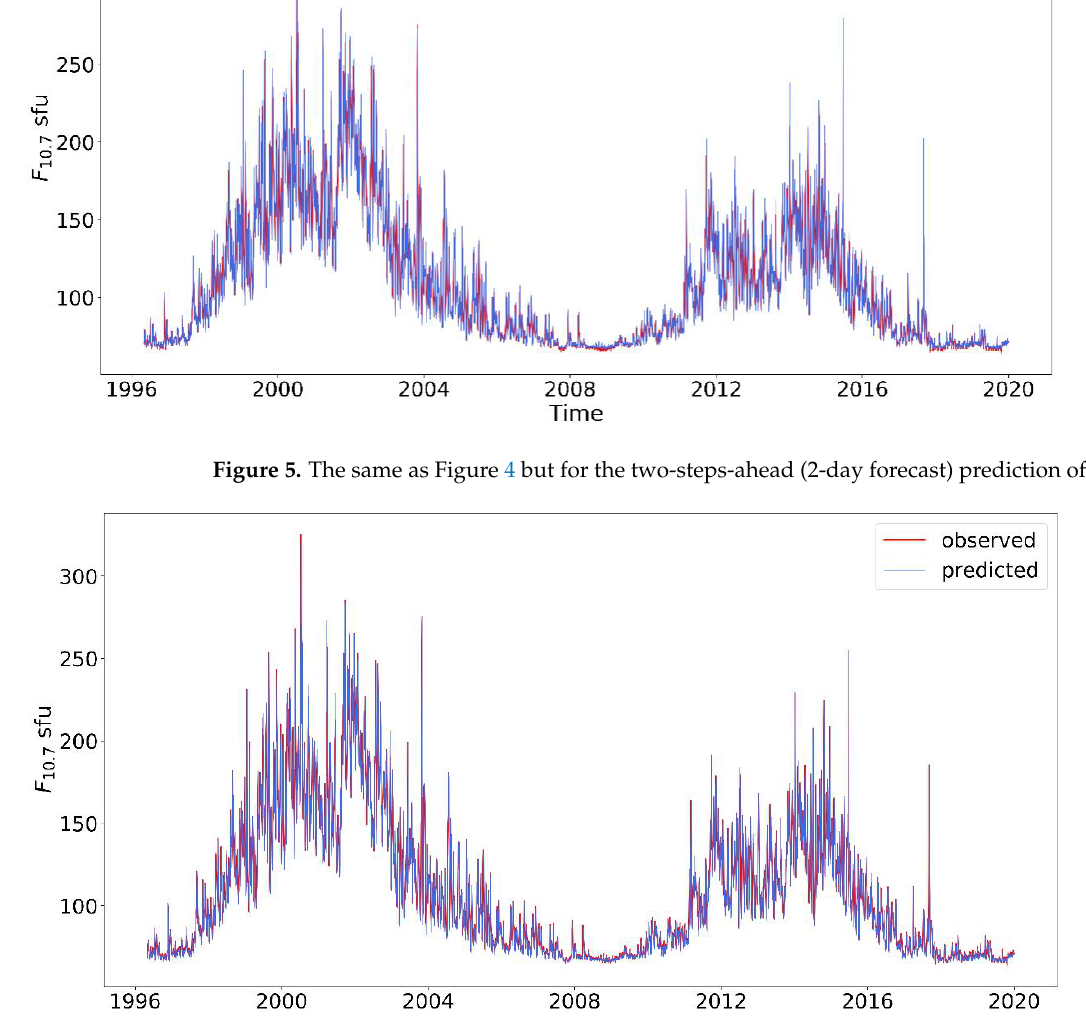
Figure 6. The same as Figure 4 but for the one-step-ahead (1-day forecast) prediction of LSTM.